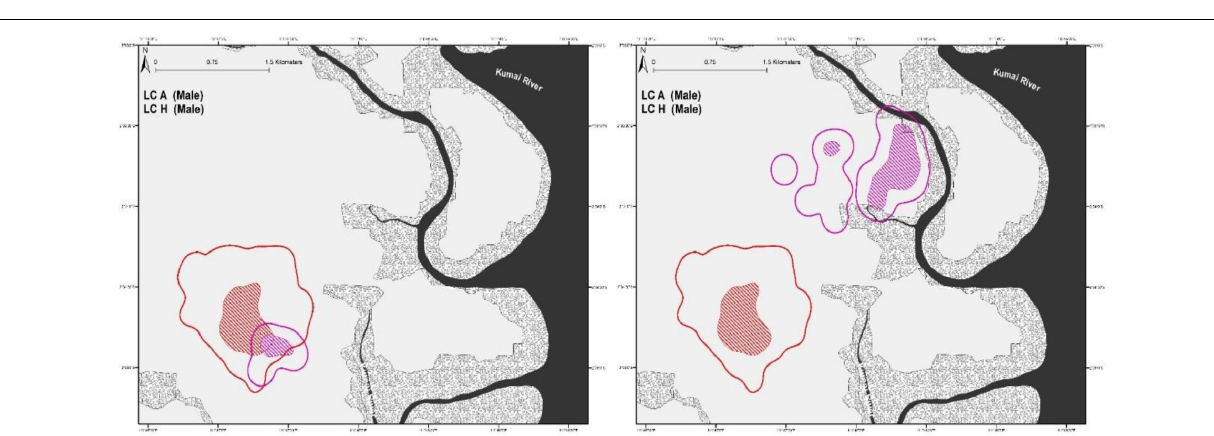
other plants. Individuals that sheltered in such areas were